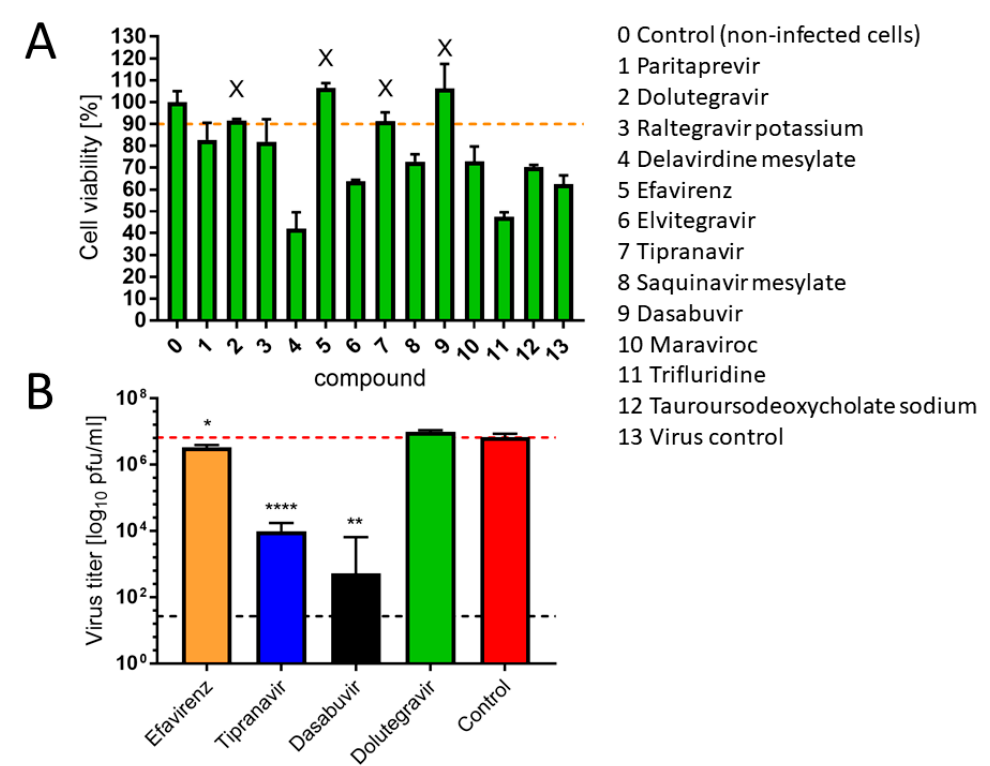
Figure 2. During the initial screening, all compounds identified by the molecular docking were tested at a single concentration of 50 µ M for inhibition of ZIKV-mediated cytopathic e ff ect (CPE) (simultaneous treatment assay). Dimethyl sulfoxide (DMSO) was added to virus-infected cells as a negative control and to control, non-infected cells, at a concentration corresponding to a dilution of the initial drug–DMSO stock. Culture medium containing appropriate drug concentrations and virus inoculum (multiplicity of infection = 0.1) was added to the cell monolayers. After 48 h of incubation at 37 ◦ C, culture media were collected, and CPE was quantified using the Cell Counting Kit-8 and expressed as percentage of cell viability. The horizontal dashed line indicates 90% cell viability compared to uninfected cells ( A ). Inhibitory e ff ect of the compounds that reduced ZIKV-mediated CPE ( > 90% viability of the cells in the culture compared to the uninfected cells; marked by X in (A)) on ZIKV growth, as determined by plaque assay. Horizontal dashed line indicates the minimum detectable threshold of 1.44 log 10 pfu / mL (black), and the mean virus titer in control (untreated) cells (red). Data were analyzed by Student’s t -test (GraphPad Prism, version 7.04); *, p < 0.05; **, p < 0.01; ****, p < 0.0001 ( B